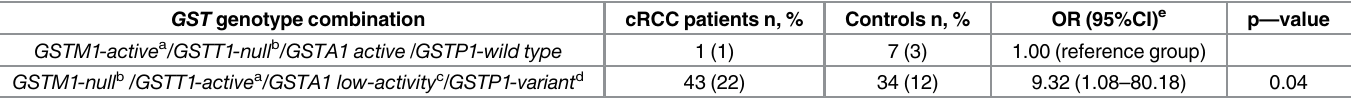
Table 5. GST genotypes in relation to the risk of cRCC.